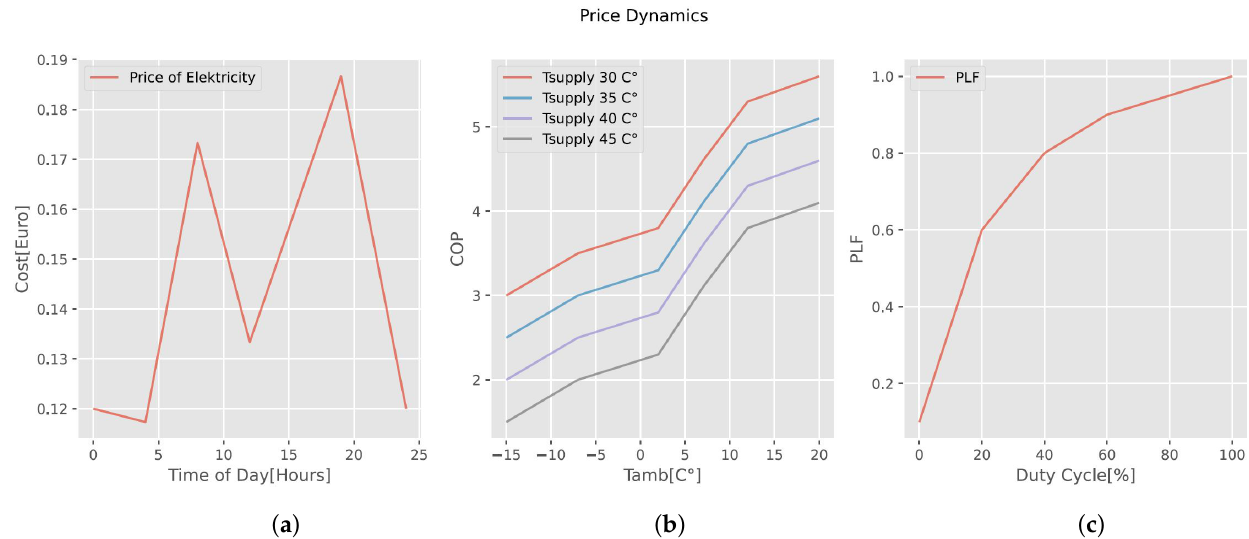
Figure 4. Dynamics of a heat pump: ( a ) Shows the average electricity prices, including taxes in Denmark as a function of the time of day (tod). ( b ) Shows the Coefficient of Performance(COP) as a function of the ambient temperature, for four different supply temperatures. ( c ) Shows the Partial Load Factor(PLF) as a function of the duty cycle